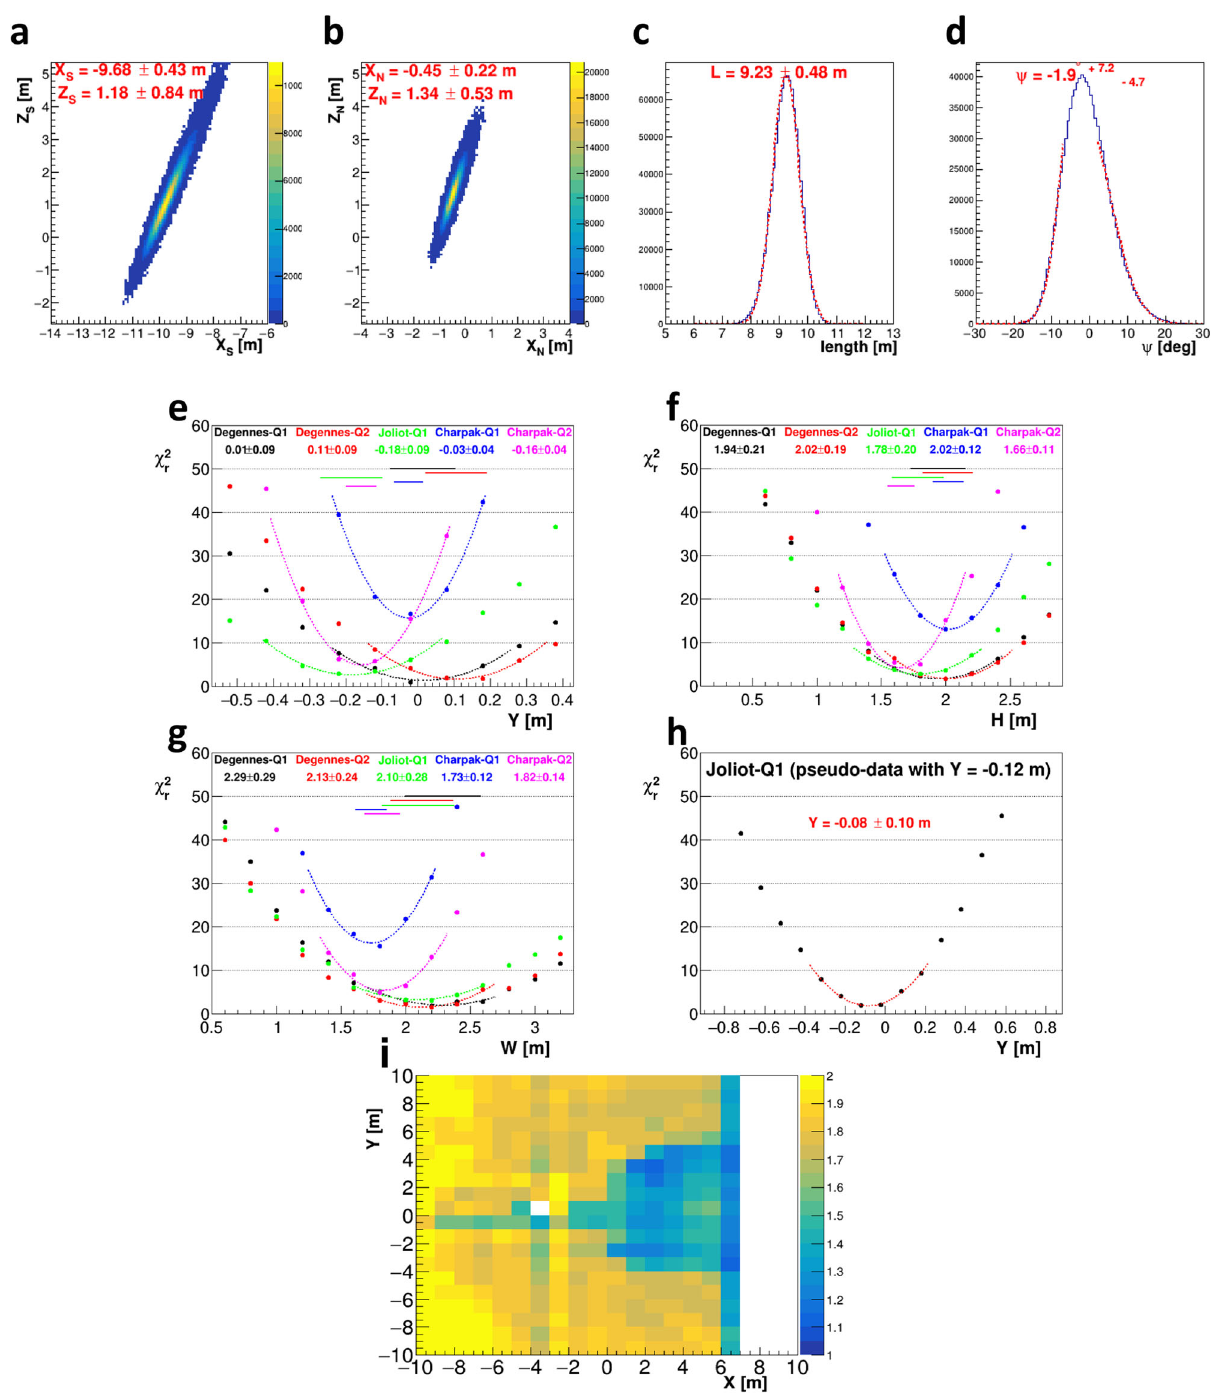
Fig.8|DeterminationofNFCcharacteristicsfromCEAdata.a , b Positionsofthe NFC extremities (South and North) obtained by random sampling within the determined cones and calculation of the corresponding intersection points. The (x;z) correlation arises from the observation direction. c , d Length and slope obtained from this sampling, with fi ts of these distribution giving mean value and error bars. e – g Results of the χ 2 method to determine the East-West shift Y , the height H and the width W of the NFC by each of the fi ve instruments: each point corresponds to a simulation with a different Y , H or W . The χ 2 is computedon a 1D